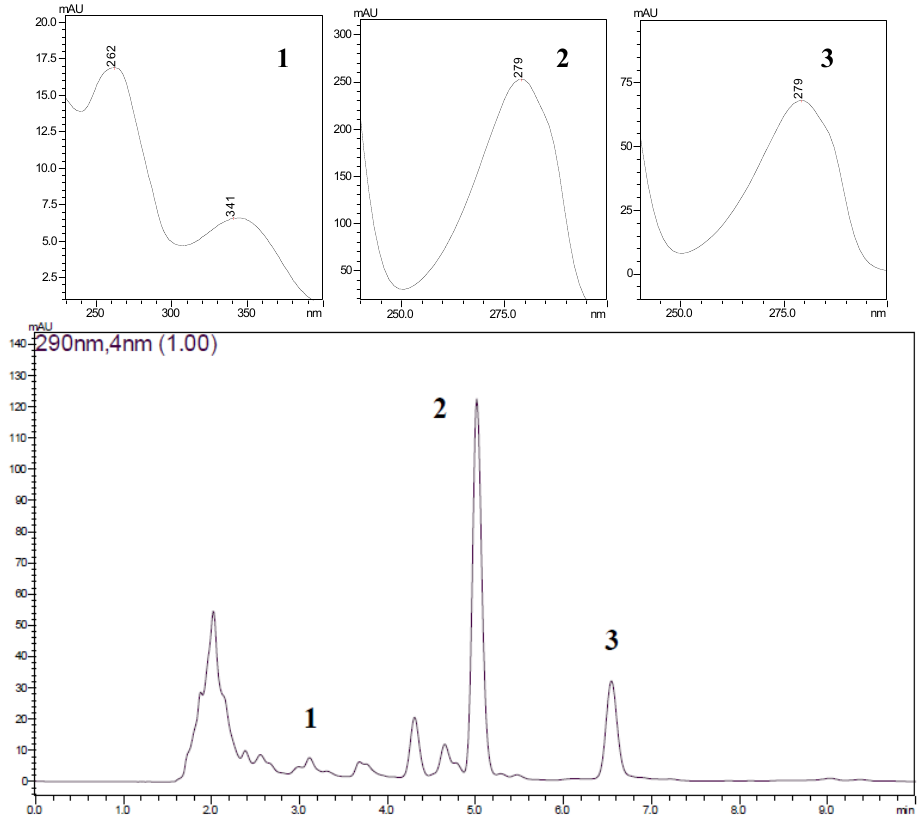
Figure 1. Chromatogram (HPLC-DAD) for an acetonitrile extract of C. frutescens whole fruits. Chrysoeriol ( 1 ); capsaicin ( 2 ); and dihydrocapsaicin ( 3